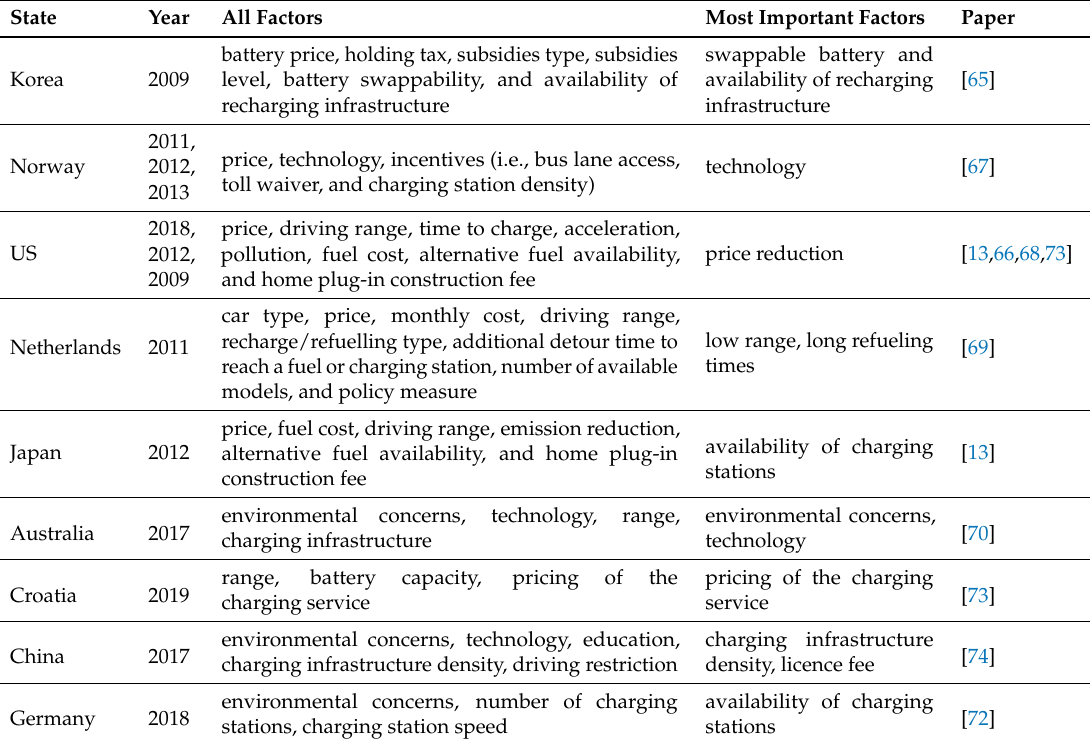
Table 2. Comparison of important factors for purchasing electric